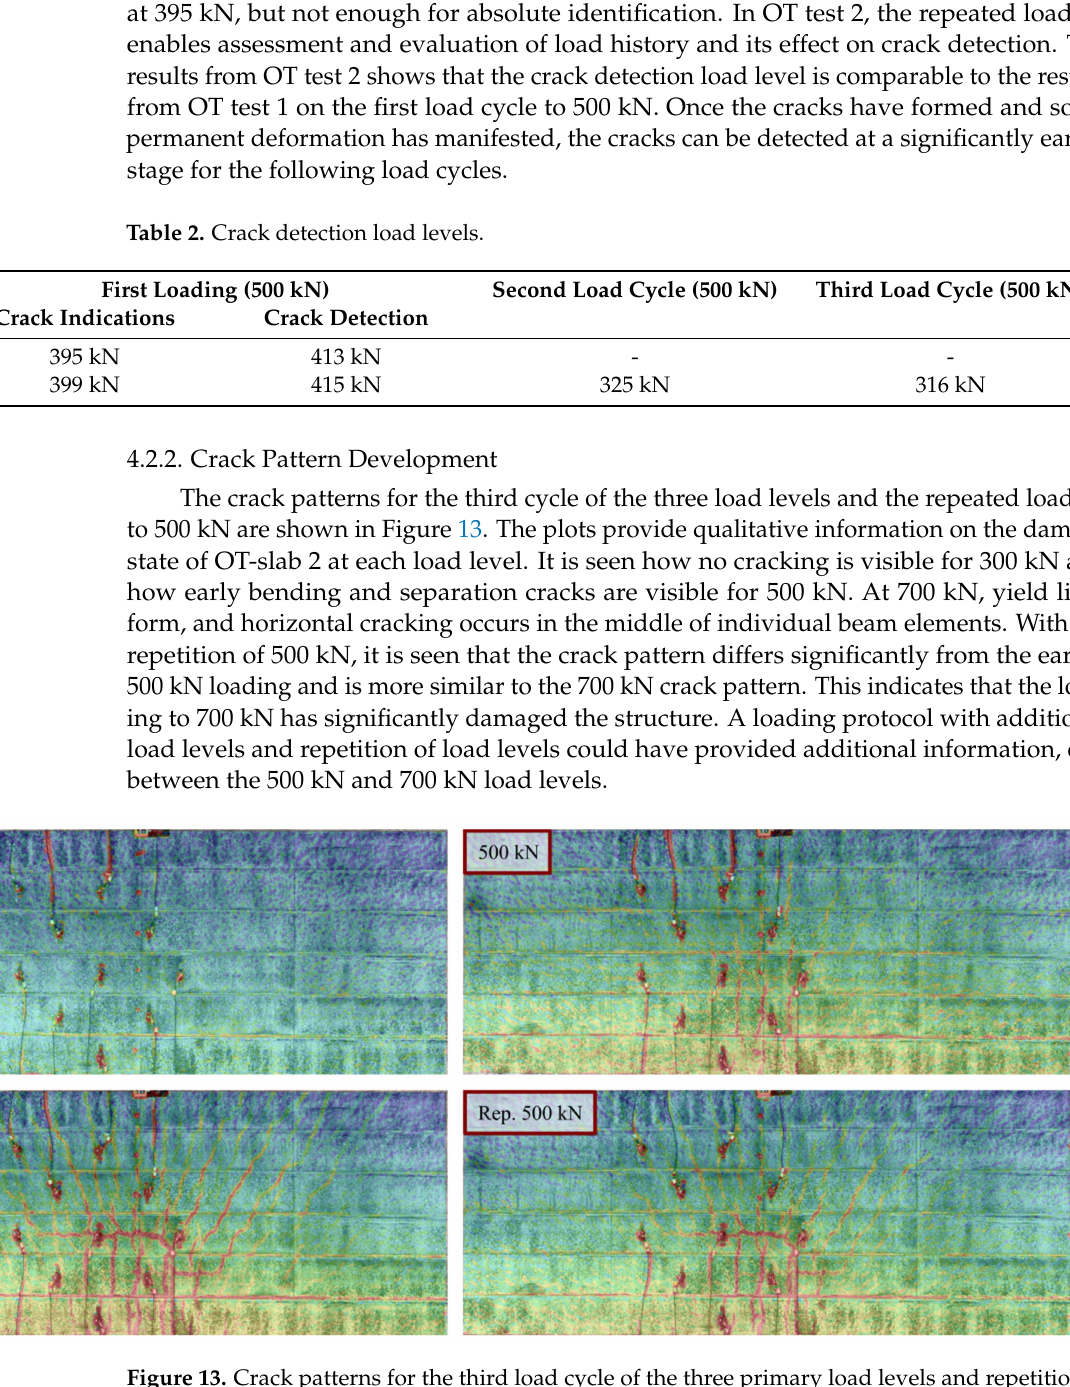
Figure 13. Crack patterns for the third load cycle of the three primary load levels and repetition of the second load level to 500